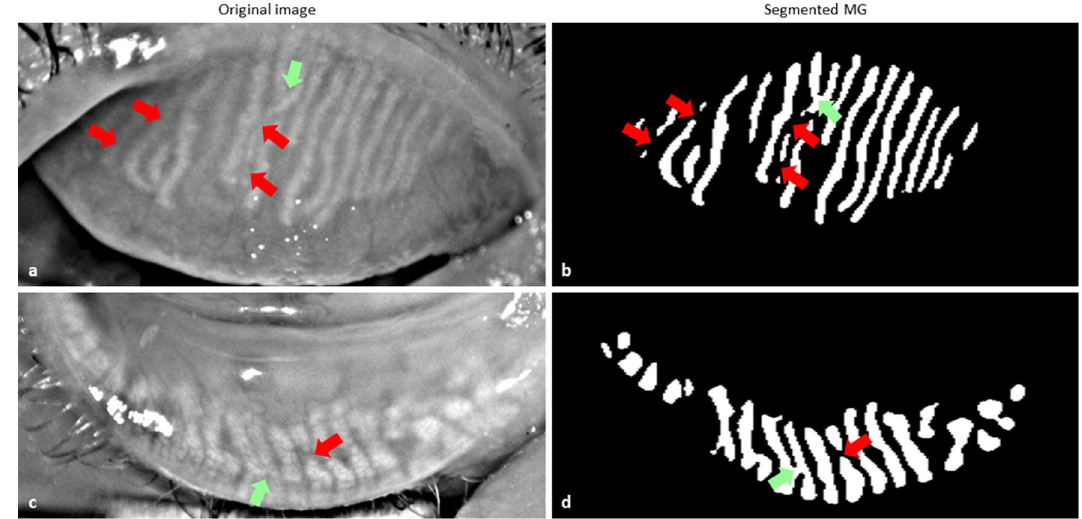
Figure 5. Example of MG segmentation where MG did not segment accurately. ( a , c ) Original images. ( b , d ) Segmented MGs. Green arrows indicate the MGs where glands need to appear separate and red arrows indicate where MGs need to become continuous. Upper eyelid parameters